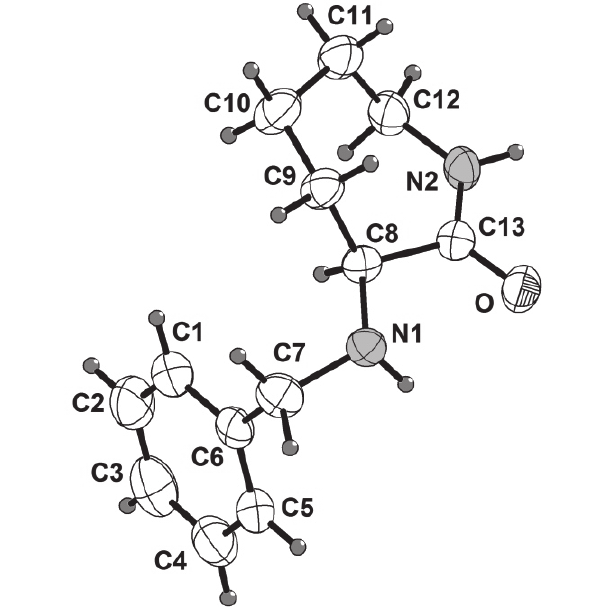
and constrained to ride on their parent atoms, with U iso (H) = 1.2 (or 1.5 for methyl groups) times U eq (C).